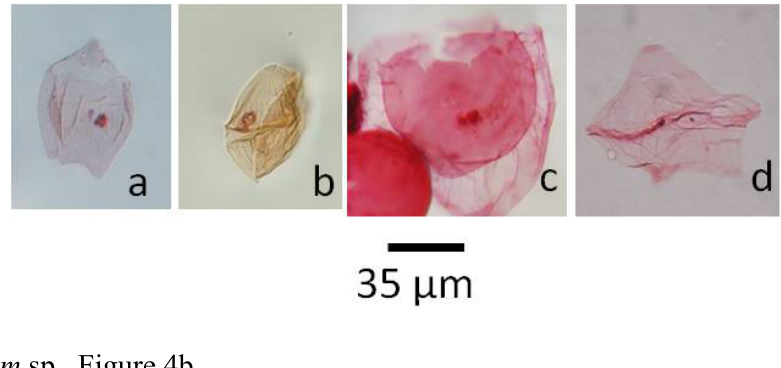
Figure 4. Cretaceous Taxa. Scale bar applies to all images. ( a ) Pierceites pentagonus , Sample 2a, slide BC2-11a: N66/2. ( b ) Dinogymnium sp., Sample 2b, slide BC2-11b: H68/2. ( c ) Riculacysta amplexa , Sample 1, slide BC2-12: J38. ( d ) Phelodinium tricuspe , Sample 2a, slide BC2-11a: